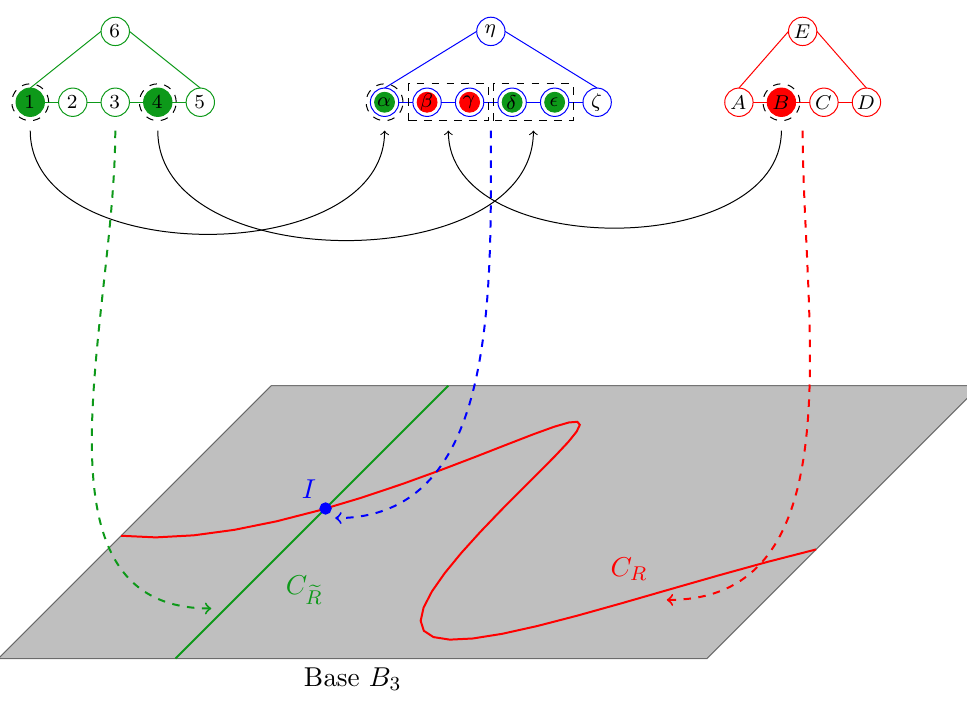
Figure 1. Schematic idea for the identi(cid:12)cation of the massless spectra of matter surface